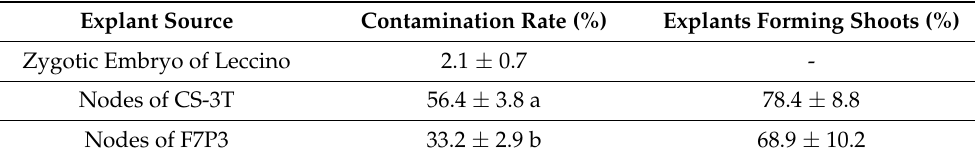
Table 1. The contamination rates of the different explant sources (immature embryos of cv. Leccino and uni-nodal explants of the cultivars CS-3T and F7P3) and the bud development from the aseptic nodal explants of both cultivars. Data have been shown as the mean ± standard deviation. The mean denoted by different letters are significantly different (Duncan’s test, p <